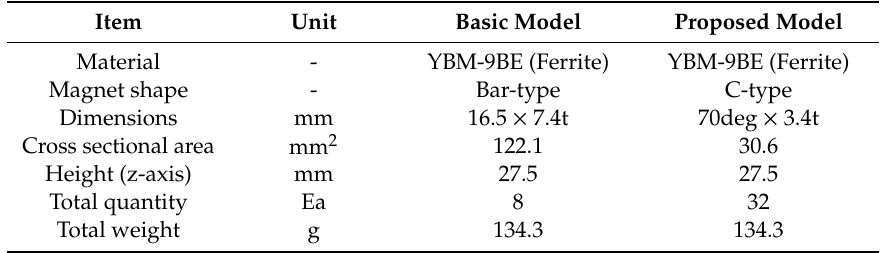
Figure 9. The magnetization direction of the proposed flared ferrite IPM model: ( a ) radial magnetization pattern; ( b ) parallel magnetization pattern; ( c ) flux density of radial magnetization pattern; ( d ) flux density of parallel magnetization pattern. Table 4. Magnet specifications of the conventional spoke model and the proposed flared